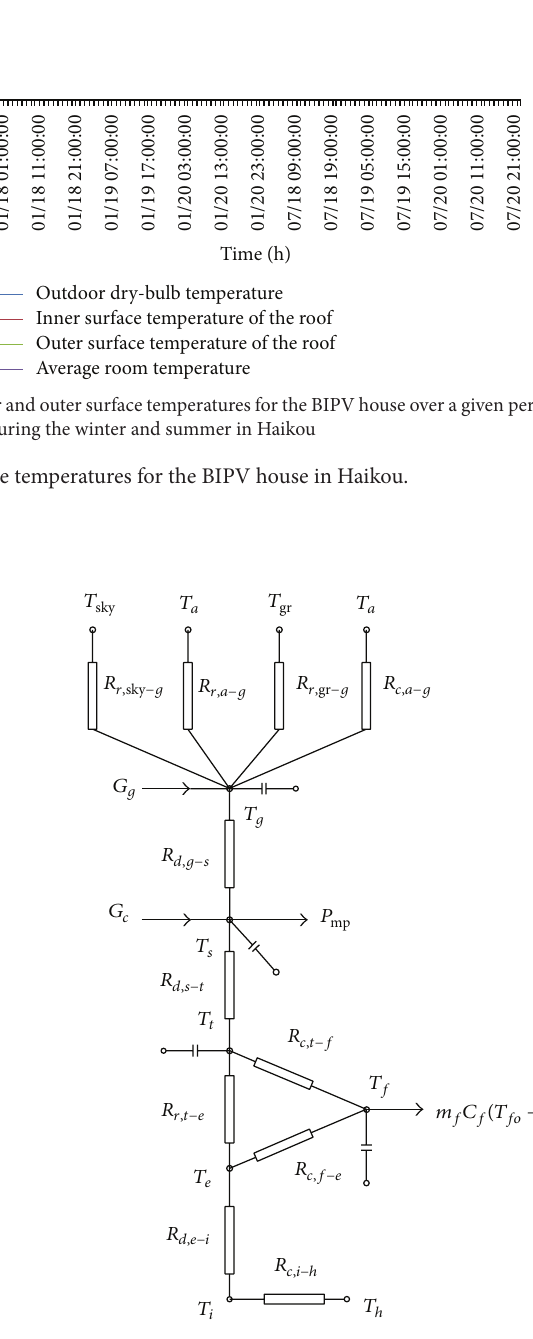
Figure 16: The 𝑅 - 𝐶 circuit used to model the ventilated air gap within the